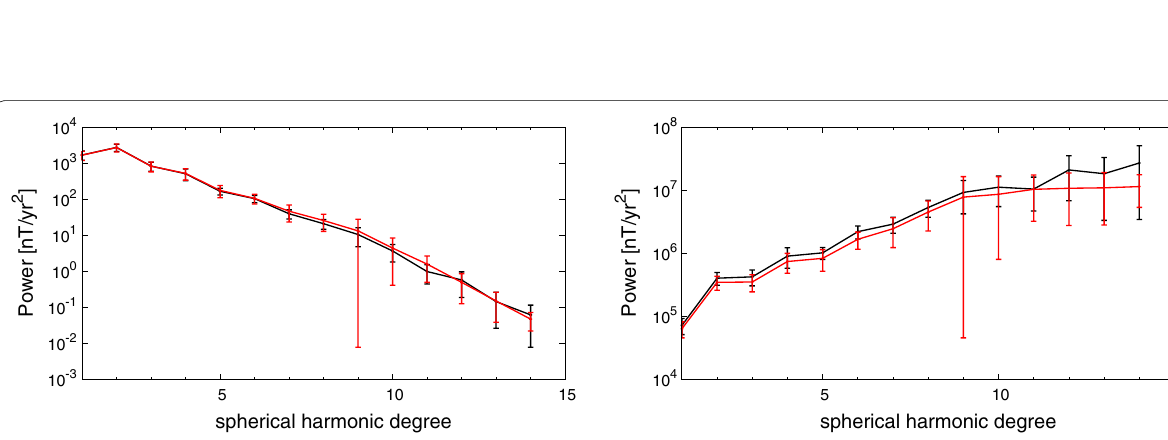
Fig. 5 The temporally averaged secular variation spectra of Models 1 and 2 at Earth’s surface (left) and at the core surface (right). Same line styles are applied as in Fig. 3. The vertical bars indicate the range, i.e., the temporal variability of the individual